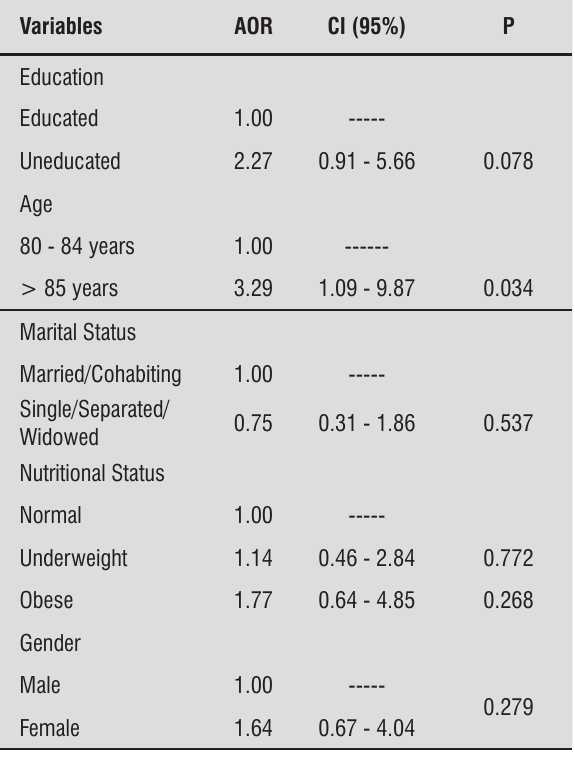
ciodemographic factors and